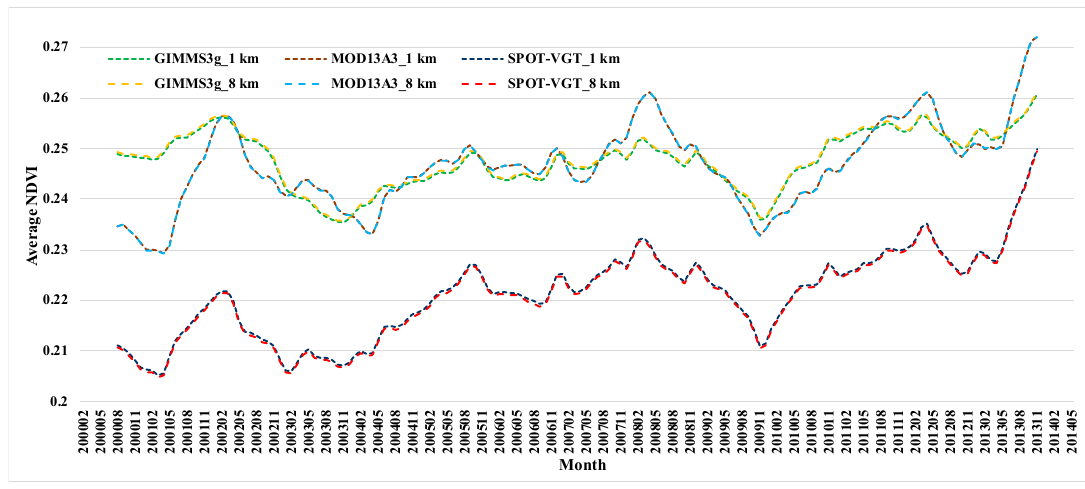
Figure 14. Trend components of decomposed average values of GIMMS3g NDVI, MOD13A3 NDVI, and SPOT-VGT NDVI in different spatial resolution (1 km and 8 km) in the MP.